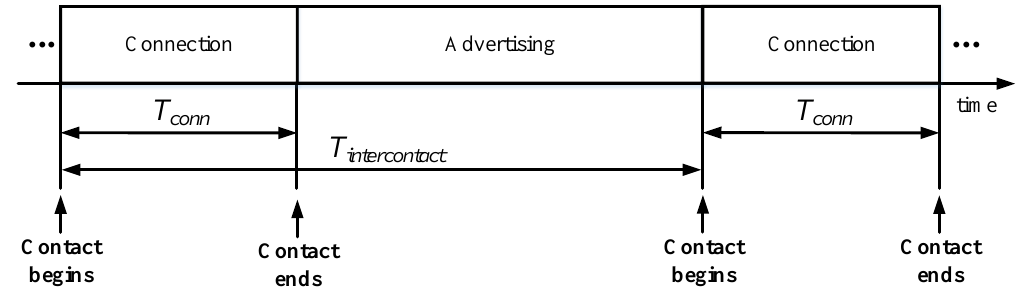
Figure 7. Illustration of time variables involved in the calculation of the average current consumption in the connection-based approach ( I avg_conn ).